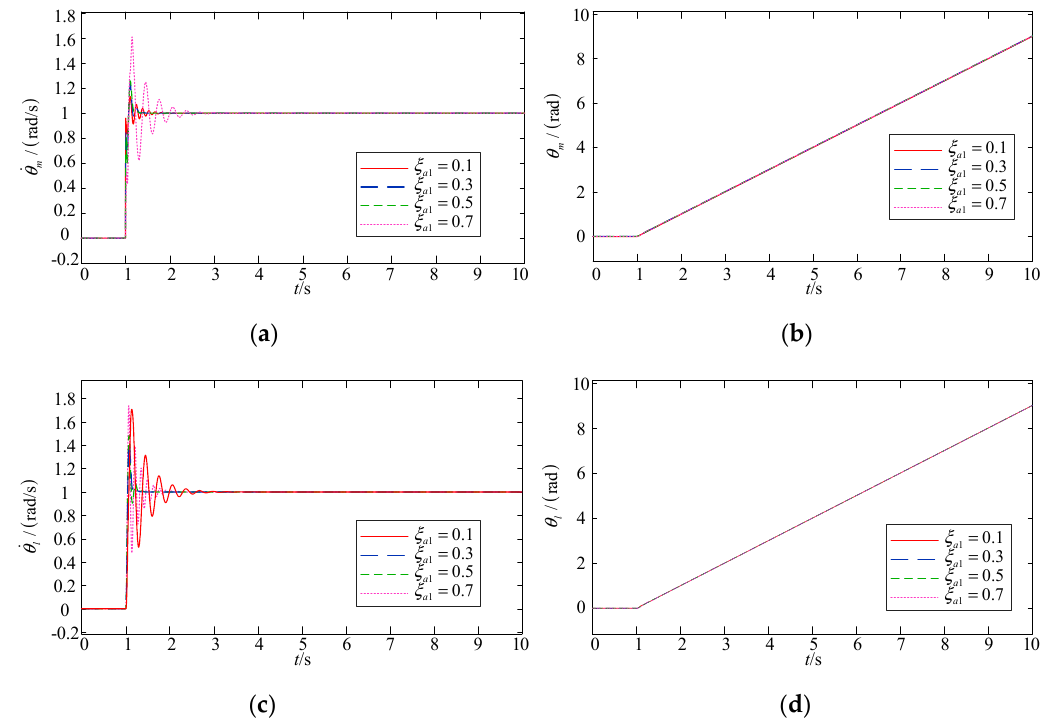
Figure 11. Simulation results under step signal. ( a ) Motor end speed output ( b ) Motor end angle output. ( c ) Load end speed output ( d ) Load end angle output.